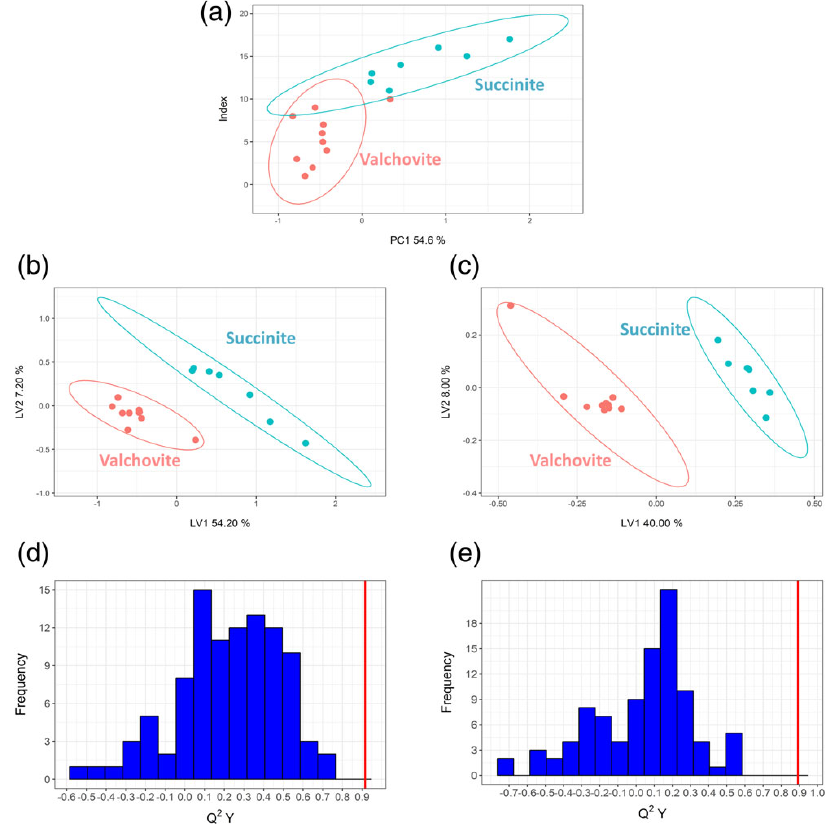
Figure 10. PCA-scores and PLS-scores plots of analyzed succinite and valchovite ambers ( a–c ). Panel (c) refers to the 1100 to 1800 cm − 1 range. Density plot of the Q 2 Y values account for the full vibrational spectra ( d ) and the 1100 to 1800 cm − 1 range ( e ). (Reproduced from work in [41] with the permission of Wiley, copyright 2017.)